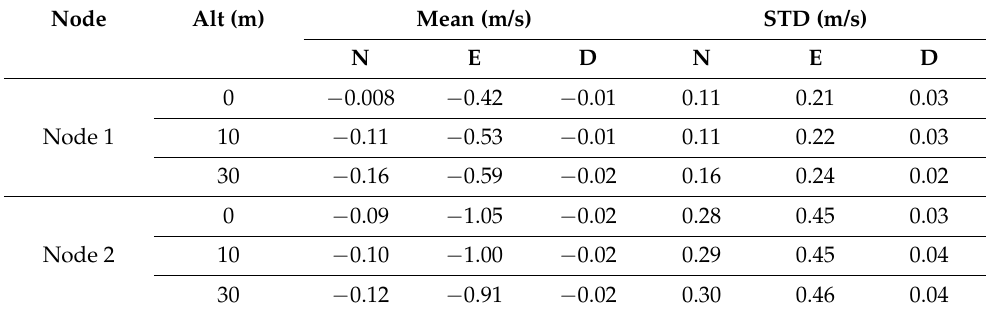
Table 8. Statistics of joint navigation positioning velocity error in the altimeter presence